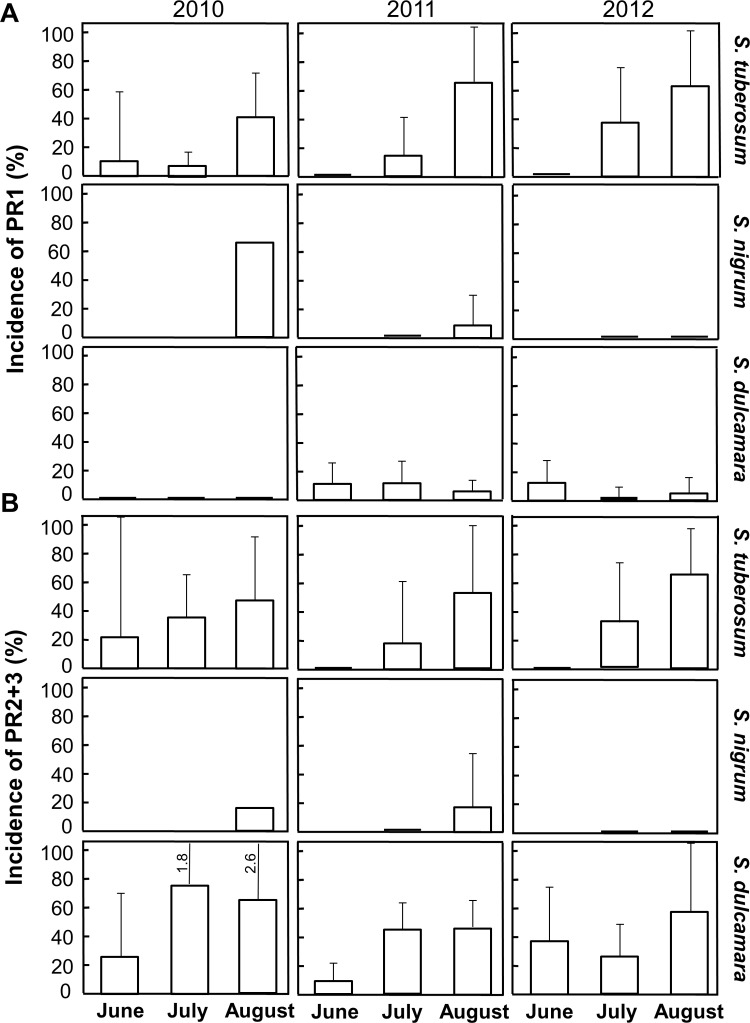
Incidence of PR proteins per species and month in cultivated Solanum tuberosum, and wild Solanum nigrum and Solanum dulcamara.Mean ± 95% CI of (A) PR1 and (B) PR2+3. Sampling was conducted in the field over three years during the three summer months per year. Numbers indicate the maximum value of large error bars. Statistical test results are given in the text. See S1 Table for a list of field locations.